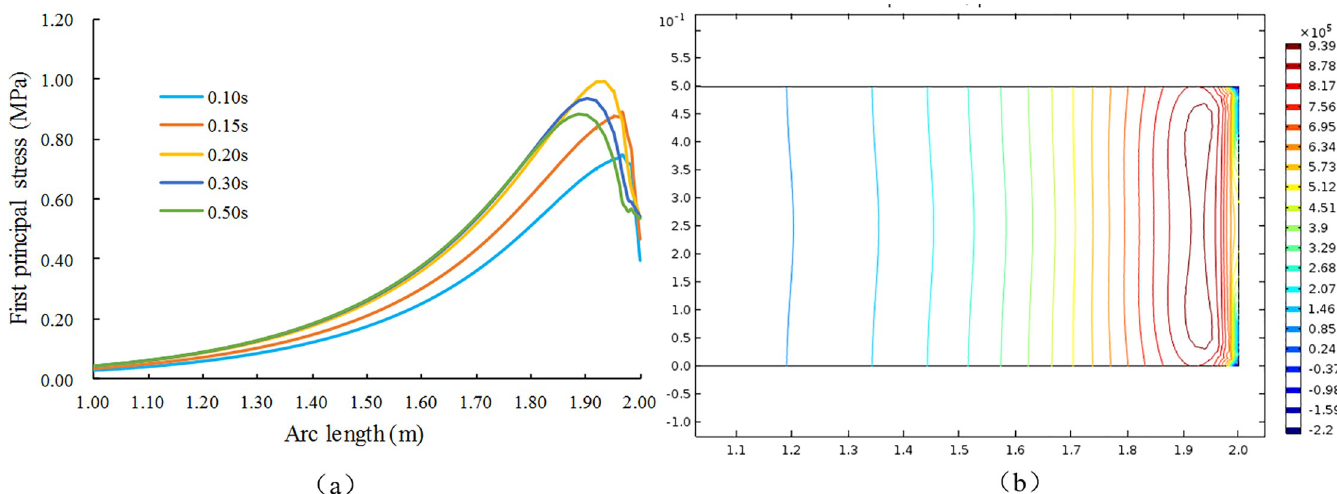
Fig 8. Distribution of the first-principal stress in the X direction and distribution of regional contours at t = 0.1 s.